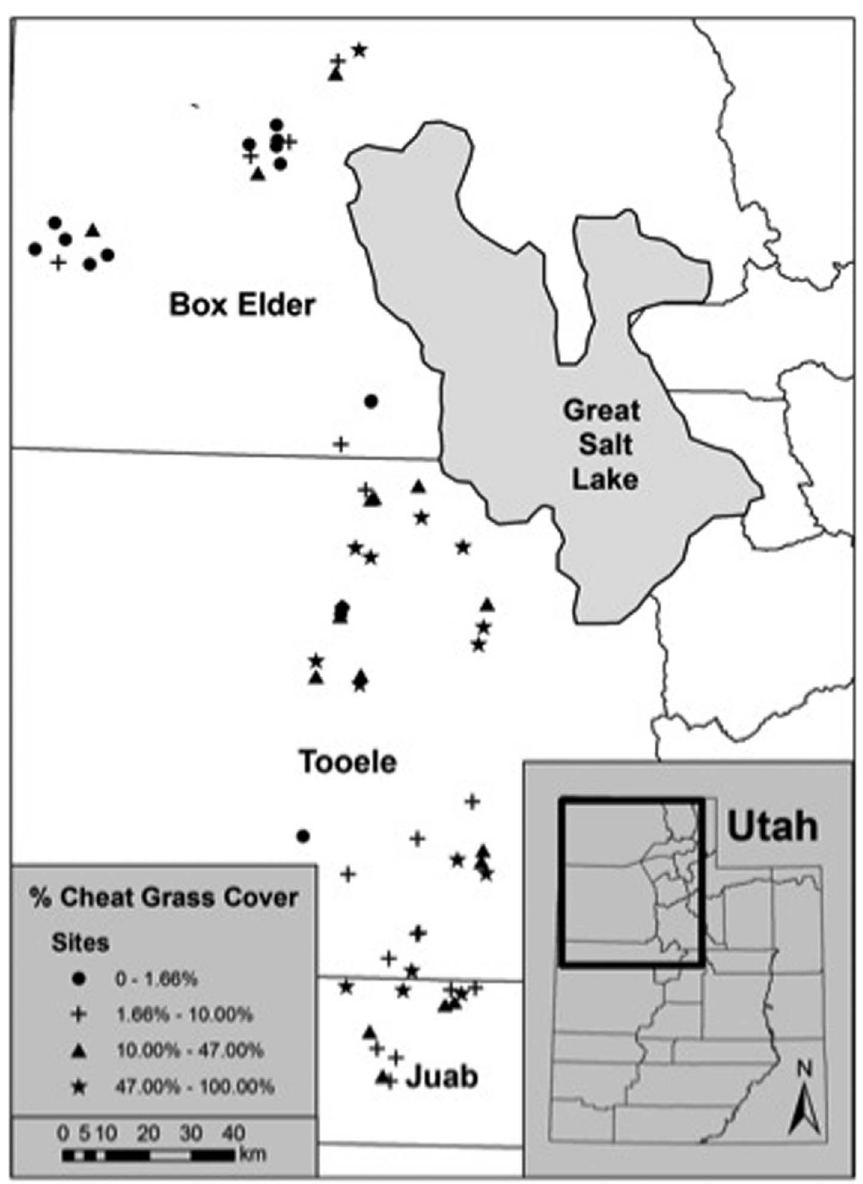
Figure 1. Study Area. Sites sampled for small mammals and the percentage of cheatgrass ( Bromus tectorum ) cover in the Great Basin Desert, Utah during the summers of 2011 and 2012. We divided sites into quartiles based on the percentage of cheatgrass cover.